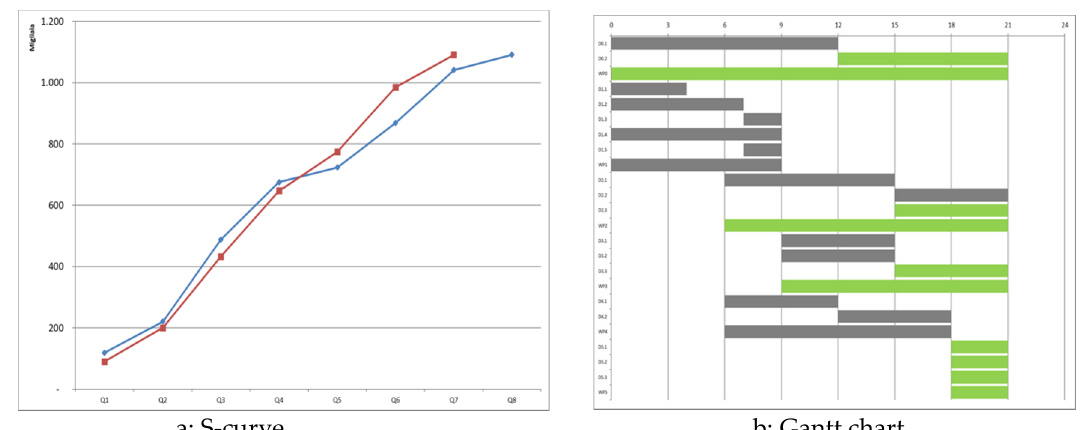
Figure 6. E-Navigation. Figure 6.